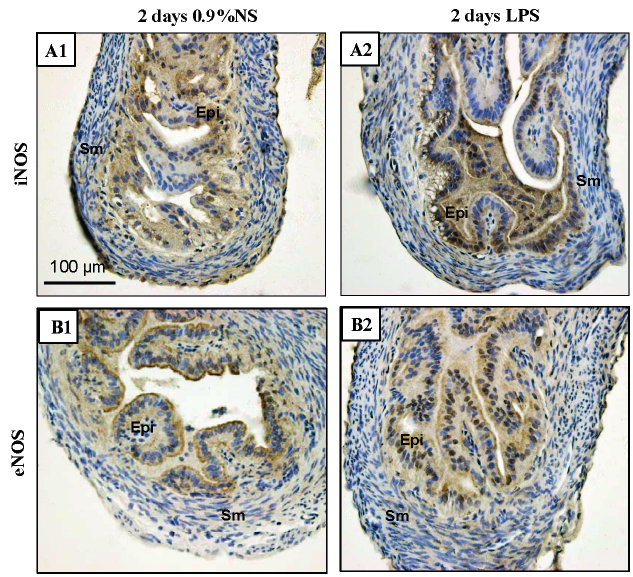
Figure 8. Immunochemical detection of iNOS and eNOS expression in the mouse Fallopian tubes after injection of LPS for two days. ( A1 , A2 ) iNOS expression in Fallopian tubes of mice treated with 0.9% NS compared with LPS (1 mg/kg body weight). iNOS expression was stronger in LPS-treated group and present in both the cytoplasm and nuclei of the epithelial cells; ( B1 , B2 ) eNOS expression in Fallopian tubes of mice treated with 0.9% NS compared with LPS. eNOS was also expressed in both the cytoplasm and nuclei of the epithelial cells, but there was no obvious change in eNOS expression in the Fallopian tubes of the LPS-treated mice compared to the 0.9% NS. Epi, epithelial cells; Sm, smooth muscle cells; NS, normal saline. Scale bar = 100